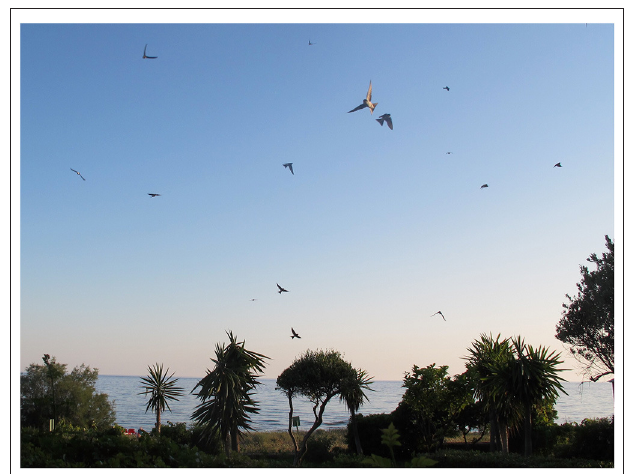
FIGURE 6 | Swifts over Corfu,